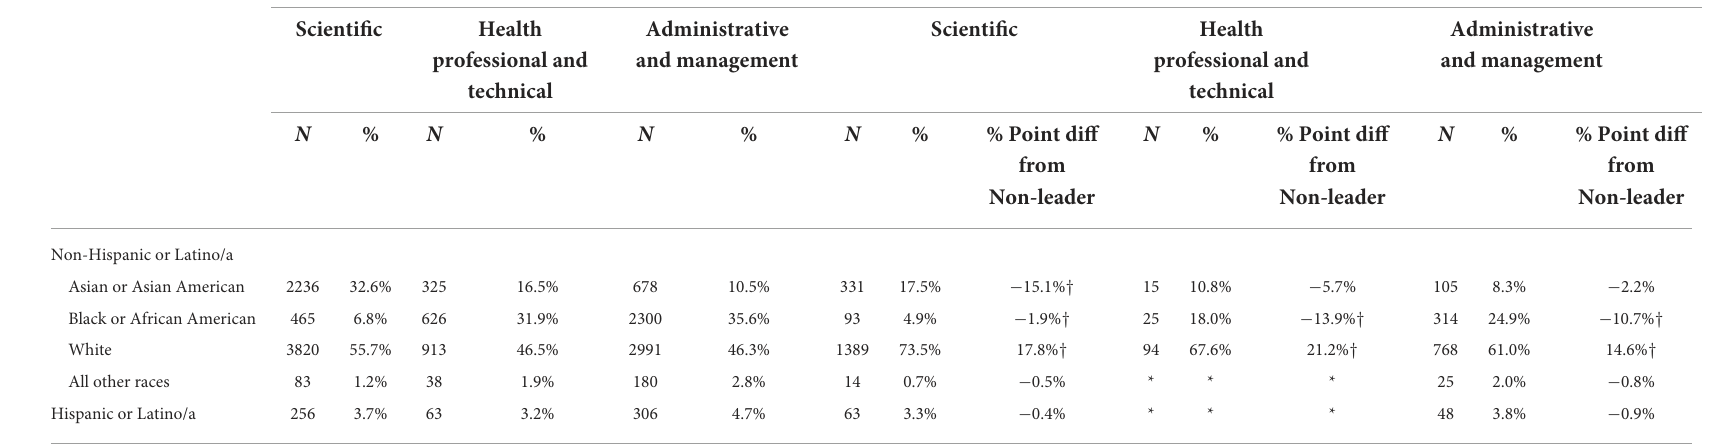
TABLE 2 Leadership gaps by race and ethnicity by occupation type in fiscal year 2021. Non-leadership positions